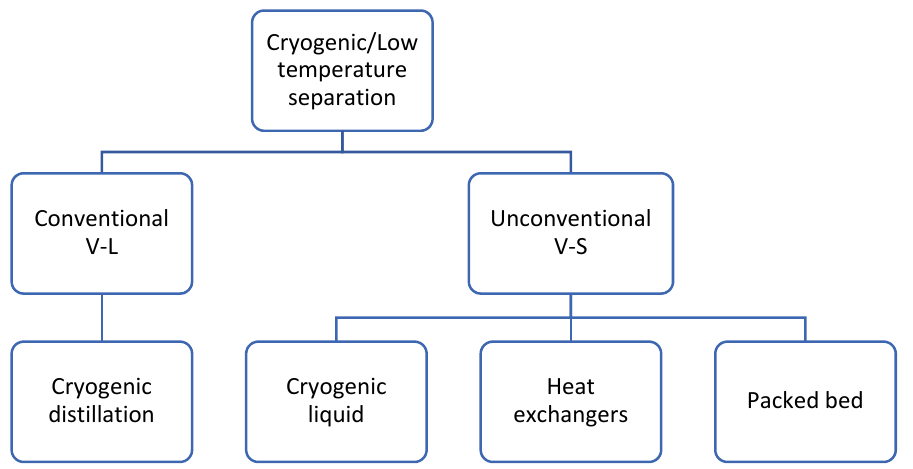
Figure 3. Cryogenic carbon capture technologies. Adaptation from [7].